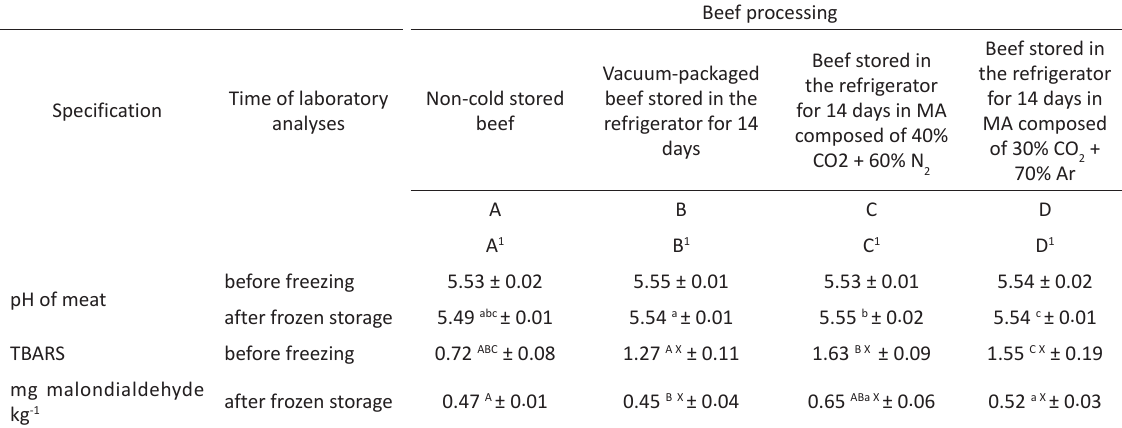
Table 2. pH of meat and TBARS